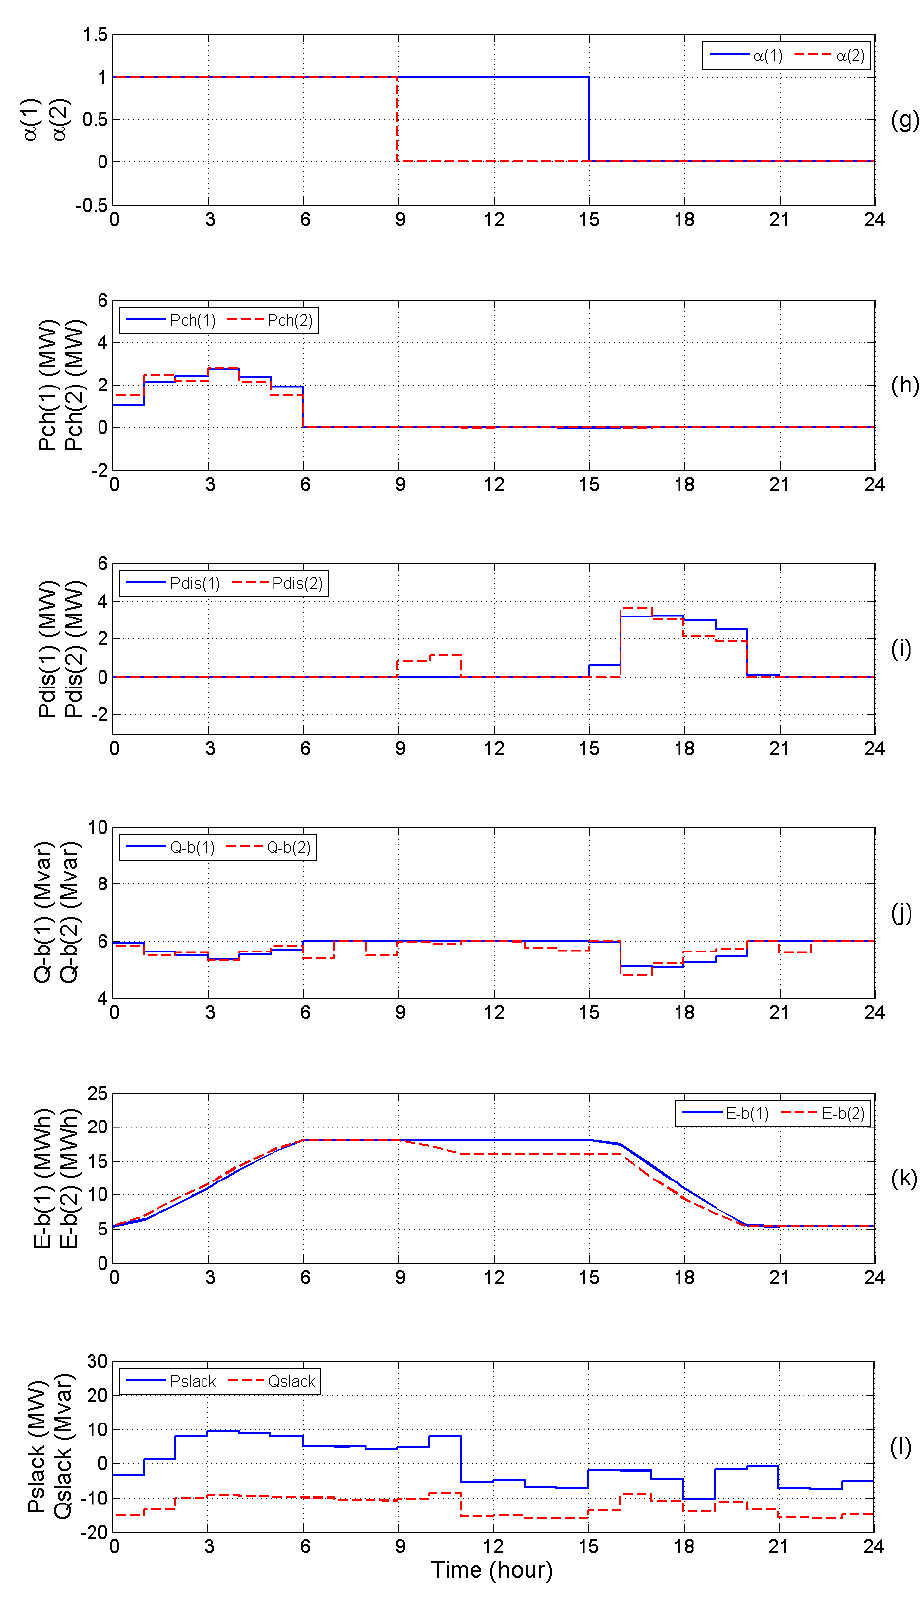
Figure 3. ( a ) Total active and reactive power demand; ( b ) Energy prices; ( c ) Wind power; ( d ) Slack bus voltage; ( e ) Curtailment factors of WFs; ( f ) Capacitive reactive power of WFs; ( g ) Binary variables for charge / discharge of BSSs; ( h ),( i ) Active power charge and discharge of BSSs, respectively; ( j ) Capacitive reactive power of BSSs; ( k ) Energy levels in BSSs; ( l ) Active and reactive power at the slack